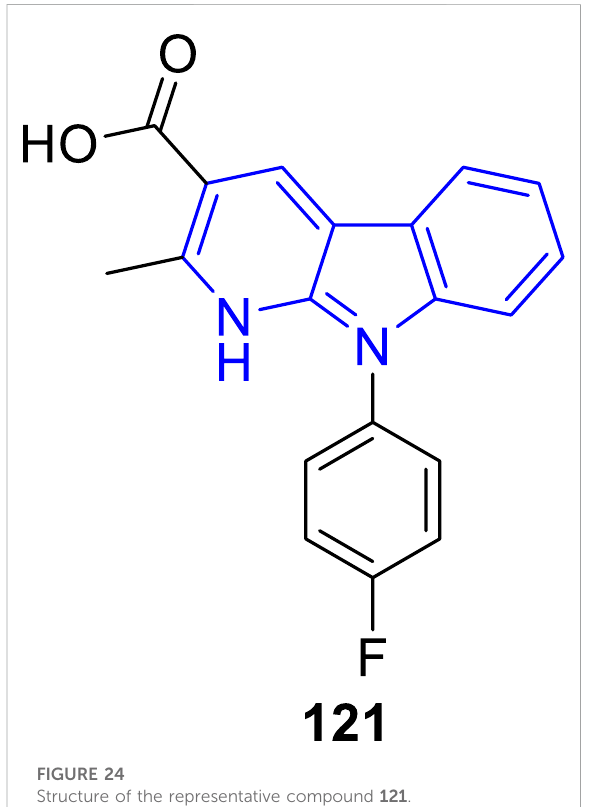
FIGURE 24 Structure of the representative compound 121 .